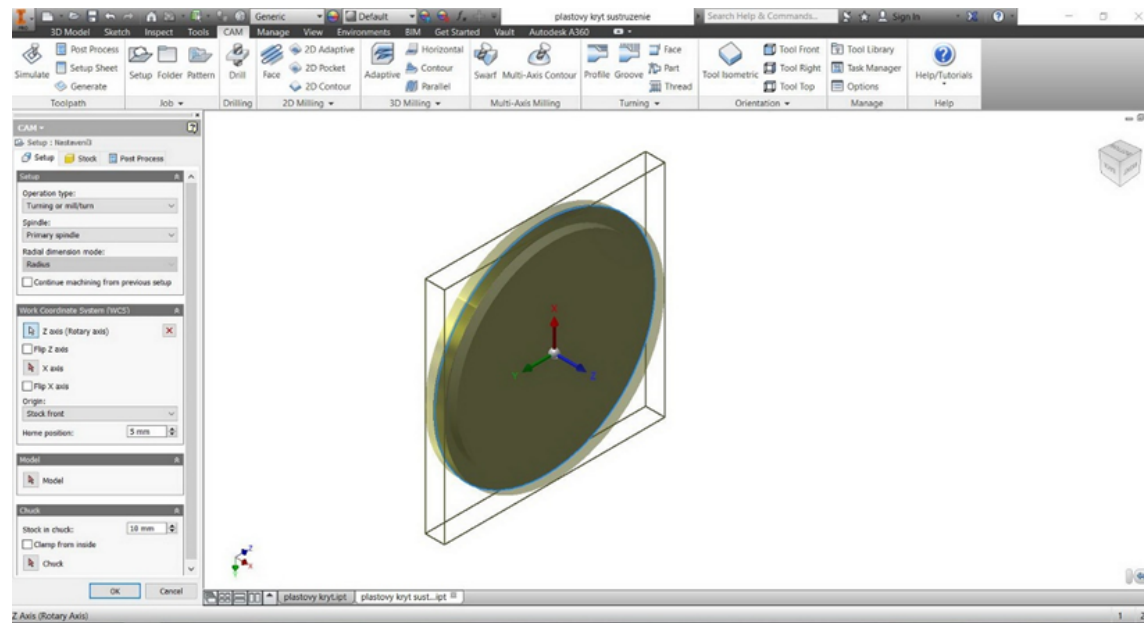
Figure 3: Location of the coordinate system on the semi-finished piece.